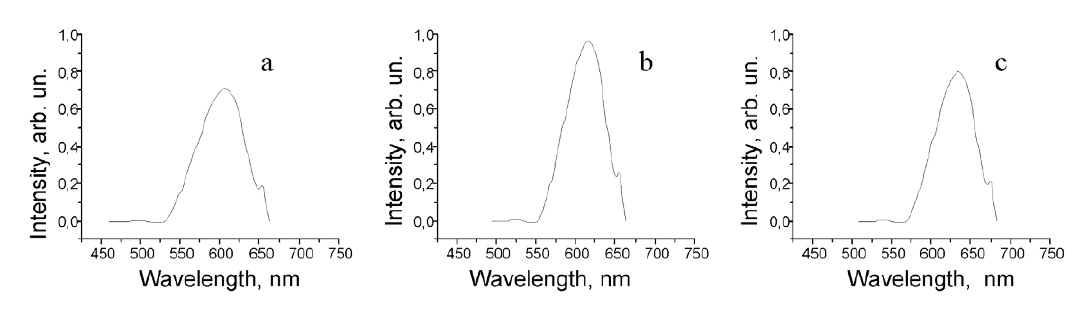
Figure 5. Experimental electroluminescent structure and its layers.